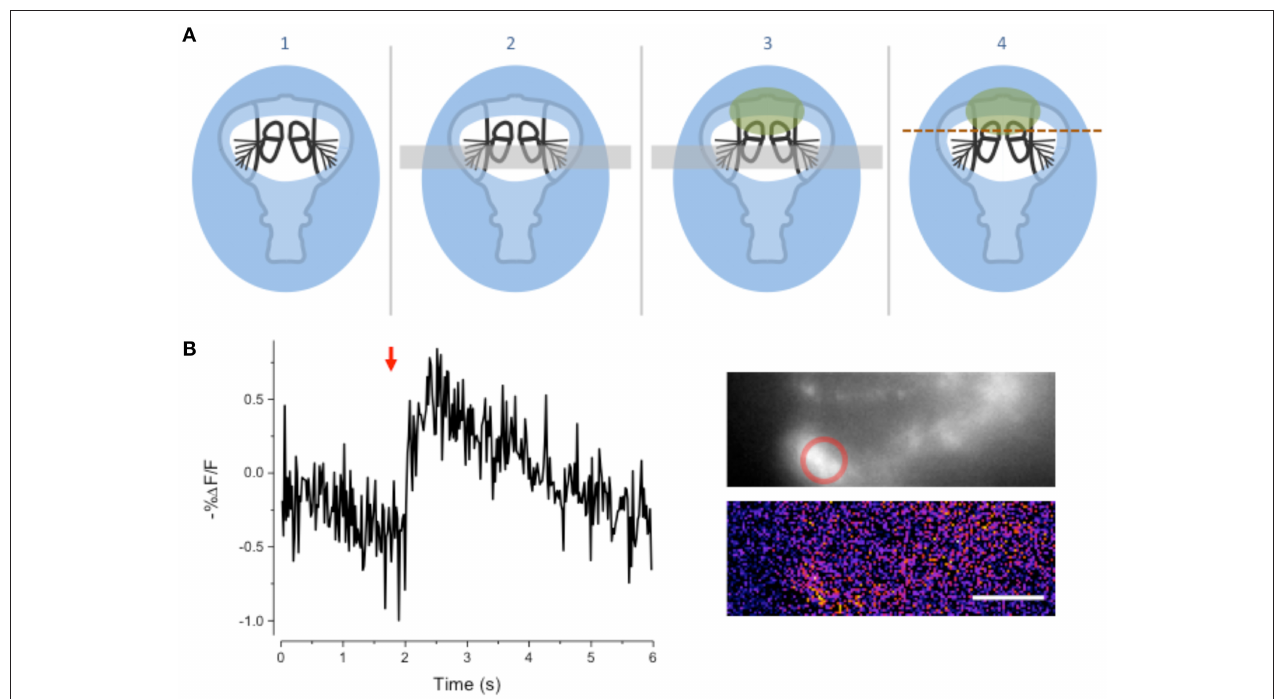
FIGURE 5 | Free-Arista Goggatomy. (A) Schematic of the procedure (1) Place the cut head on a small droplet of LCR (blue) and allowed it to sink so that its edges, but not the antennae or arista, are covered. Cure for 20 s. (2) Place a small strip of colored Cellophane (gray rectangle) over the A3, to prevent LCR from pulling the antennae up when it is applied to A2. (3) Apply a very small droplet of LCR so that it covers the dorsal margins of the A2 (green). Begin light curing, then remove the plastic strip and apply a droplet of water to the preparation. Cure for 1 min. Wick off the water with a tissue. (4) Apply DS and cut through the head as indicated by the dotted line. (B) Response of JO cells expressing GCaMP6 in a FA-goggatomized preparation to an air pulse (120 ms, ∼ 1psi) directed at the solution (red arrow). Inset top, fluorescence, bottom pseudo-color difference image. Scale bar 20 µ